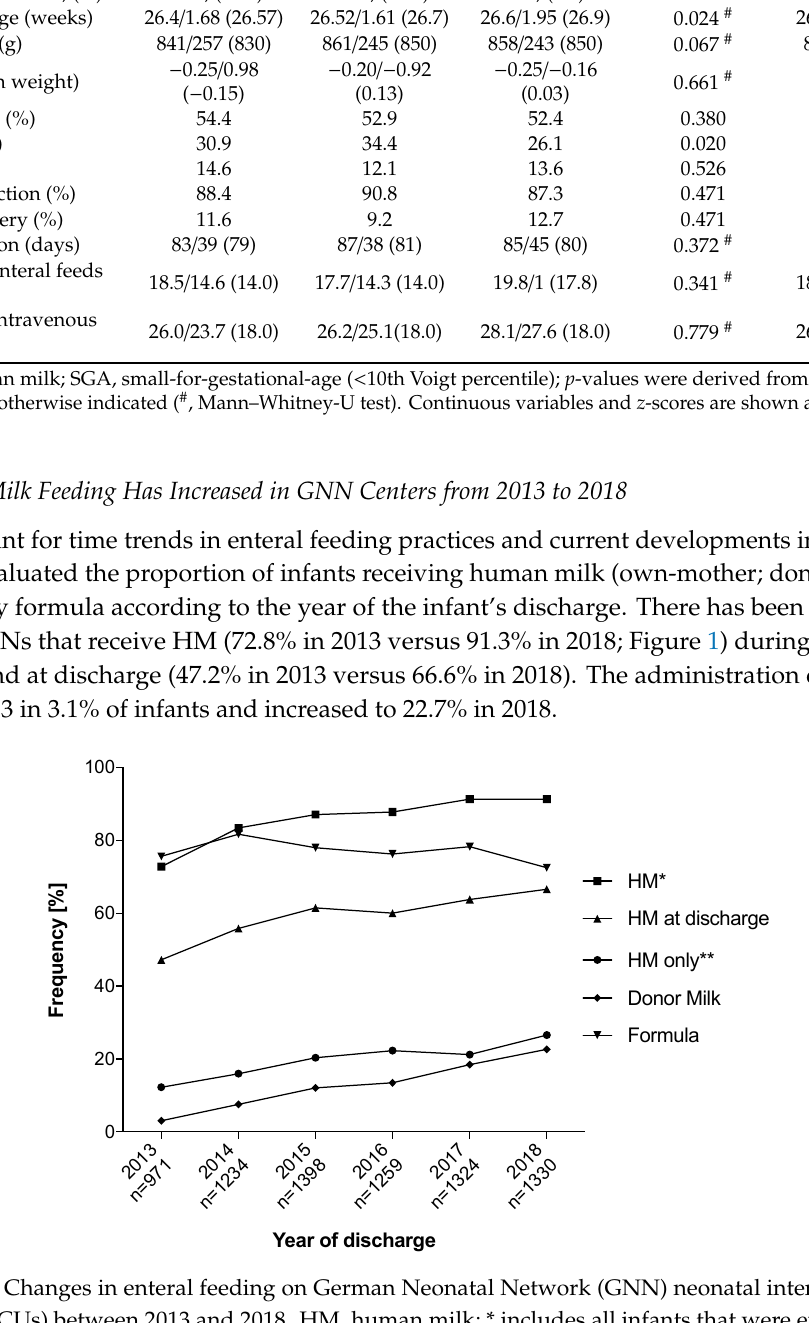
Table 4. Treatment, outcomes, and growth parameters of the GNN cohort stratified to type of milk feeding.